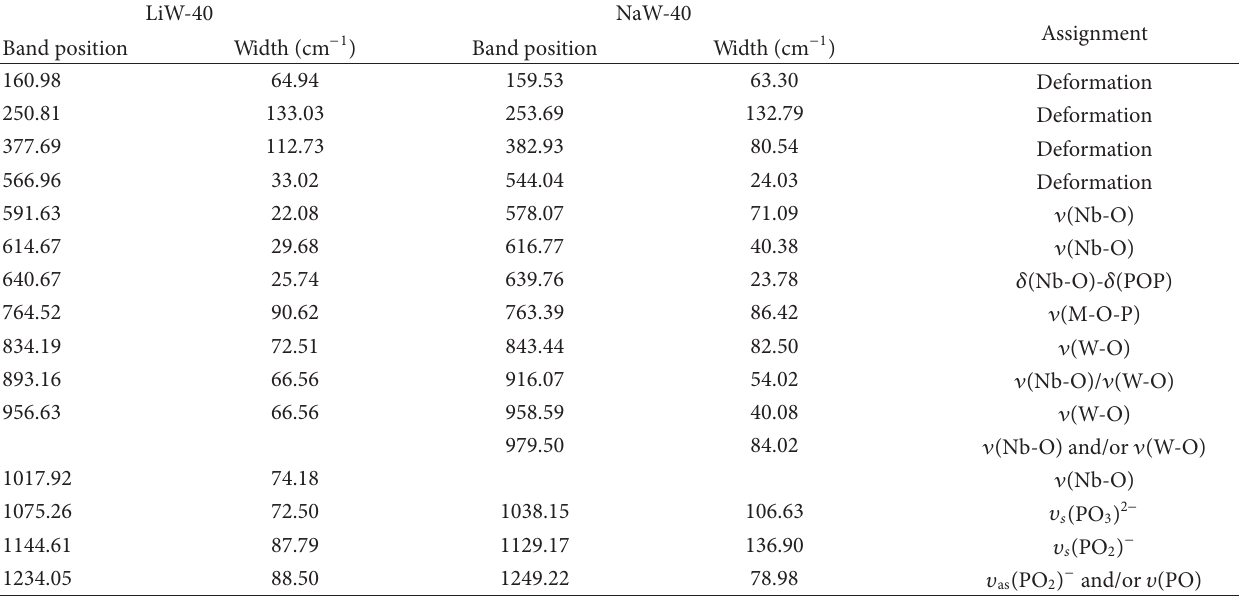
T 2: Raman band positions of the LiW-40 and NaW-40 samples and their